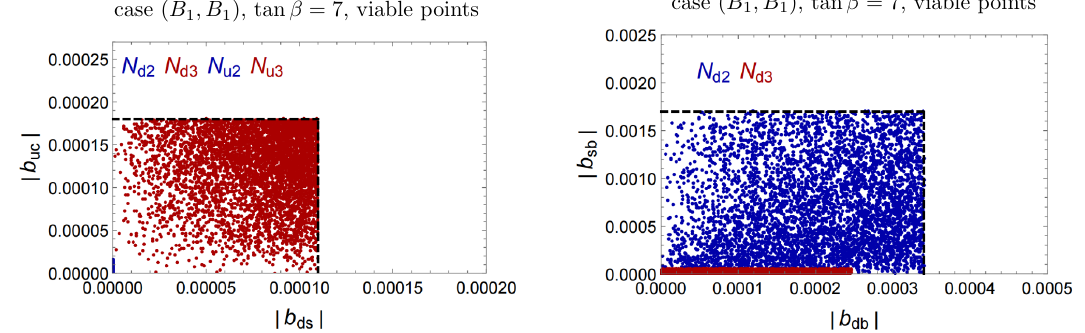
Figure 6 . Constraints from the kaon and D -meson oscillations (left) and from B / B s -meson oscil- lations (right) for the subset of points which satisfy all the meson oscillation